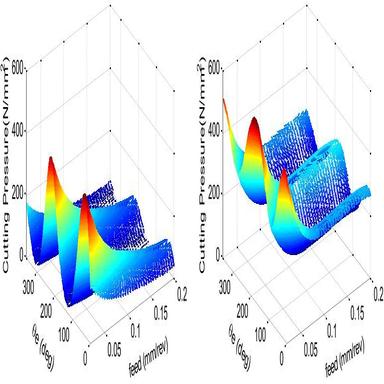
Axial cutting pressures of the (a) primary and (b) chisel cutting edges for all the feeds, and effective fibre orientation at a rotational speed of 6000 rev/min.